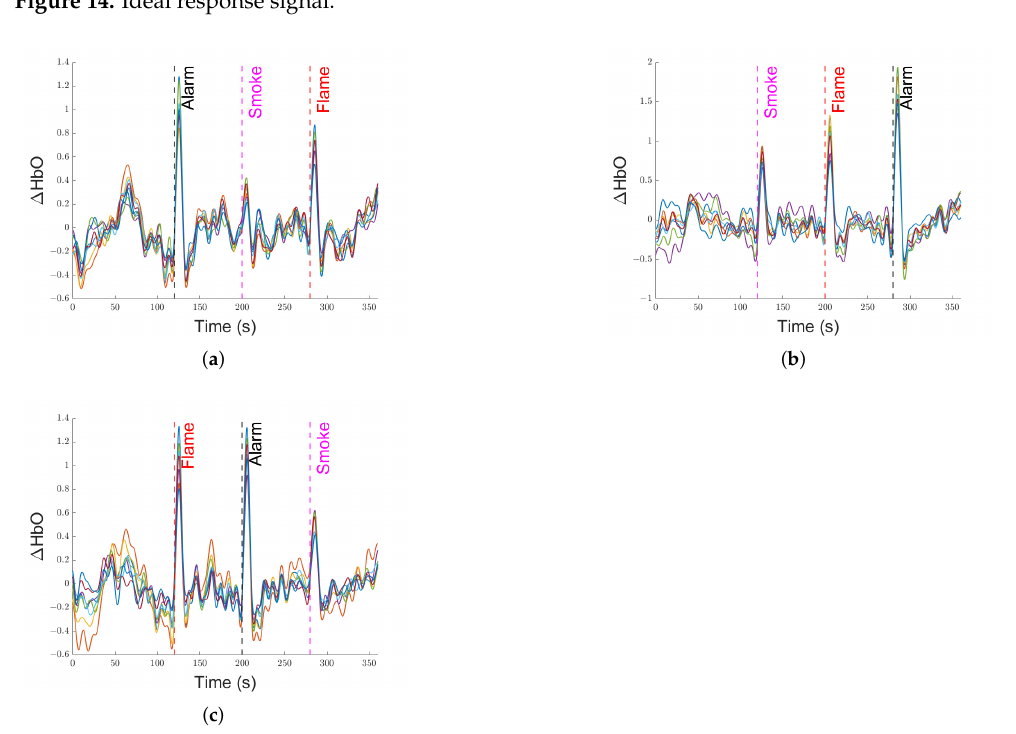
Figure 14. Ideal response signal.